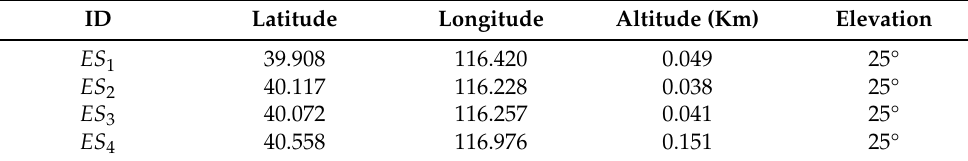
Table 2. Earth stations parameters.